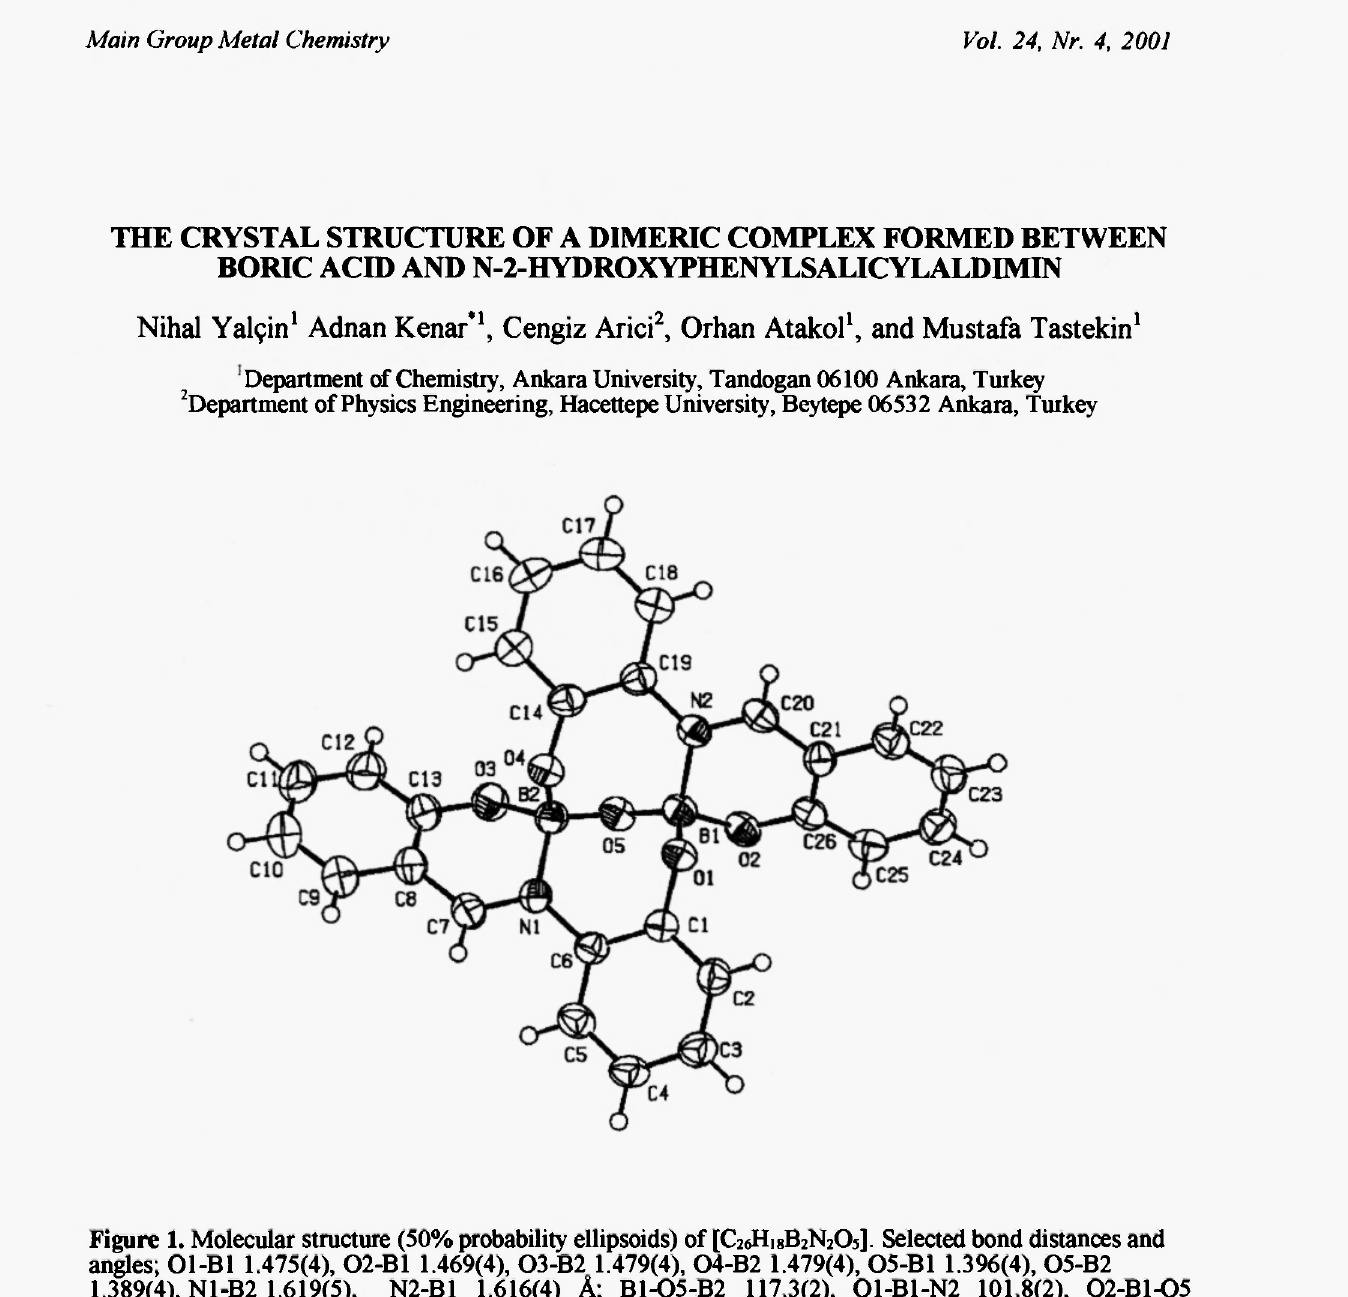
Figure 1. Molecular structure (50% probability ellipsoids) of [C20H18B2N2O5]. Selected bond distances and angles; Ol-Bl 1.475(4), 02-B1 1.469(4), 03-B2 1.479(4), 04-B2 1.479(4), 05-B1 1.396(4), 05-B2 1.389(4), N1-B2 1.619(5), N2-B1 1.616(4) Ä; B1-05-B2 117.3(2), 01-B1-N2 101.8(2), 02-B1-05 109.4(2), 02-B1-N2 107.1(2), 01-B1-02 110.1(3), 01-B1-05 115.4(3), 05-B1-N2 112.5(3), 04-B2-N1 101.7(3), 05-B2-N1 113.1(3), 03-B2-04 109.3(3), 03-B2-05 110.9(3), 03-B2-N1